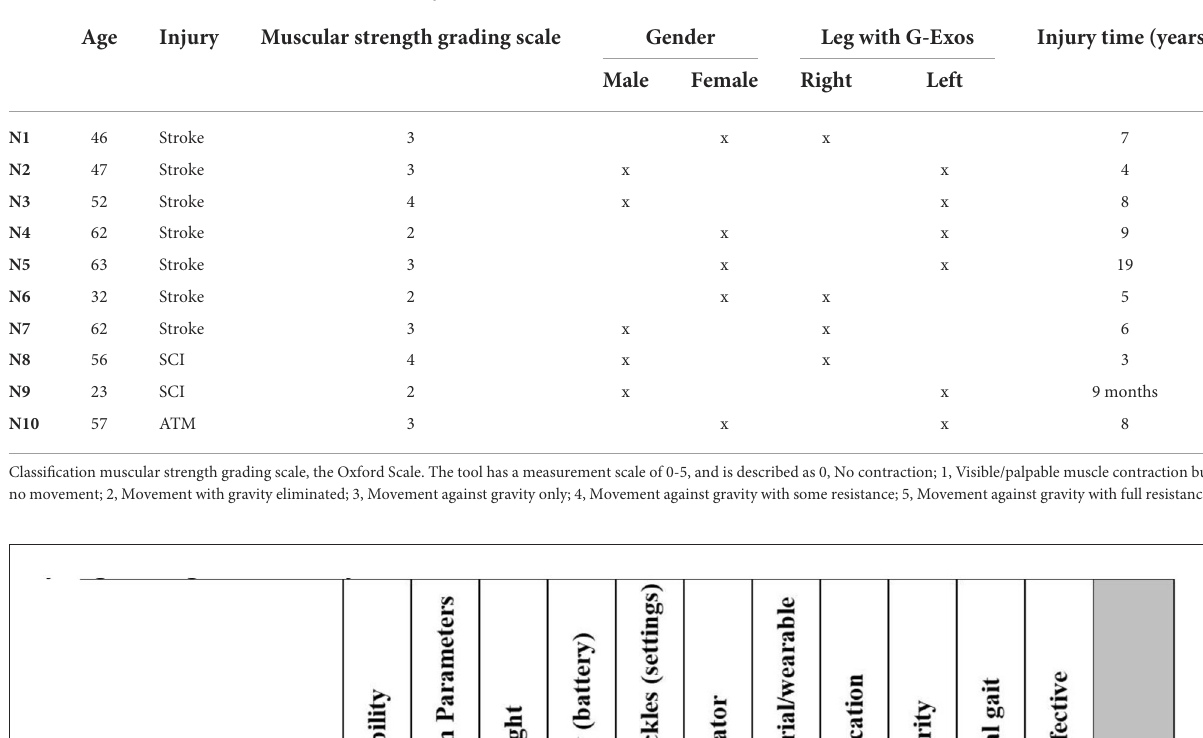
TABLE 1 Characteristics of volunteers with foot drop.